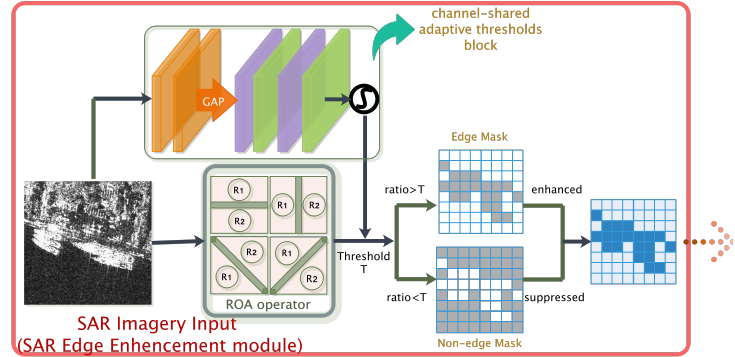
Figure 2. Description of the SAR image edge enhancement (SEE)